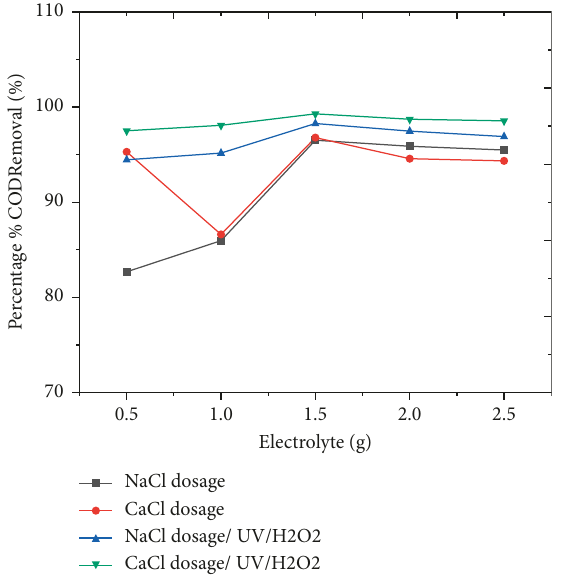
Figure 5: Effect of electrolyte concentration on COD removal efficiency by using